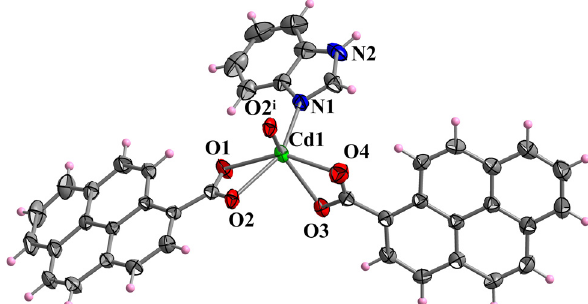
Table  : Data collection and